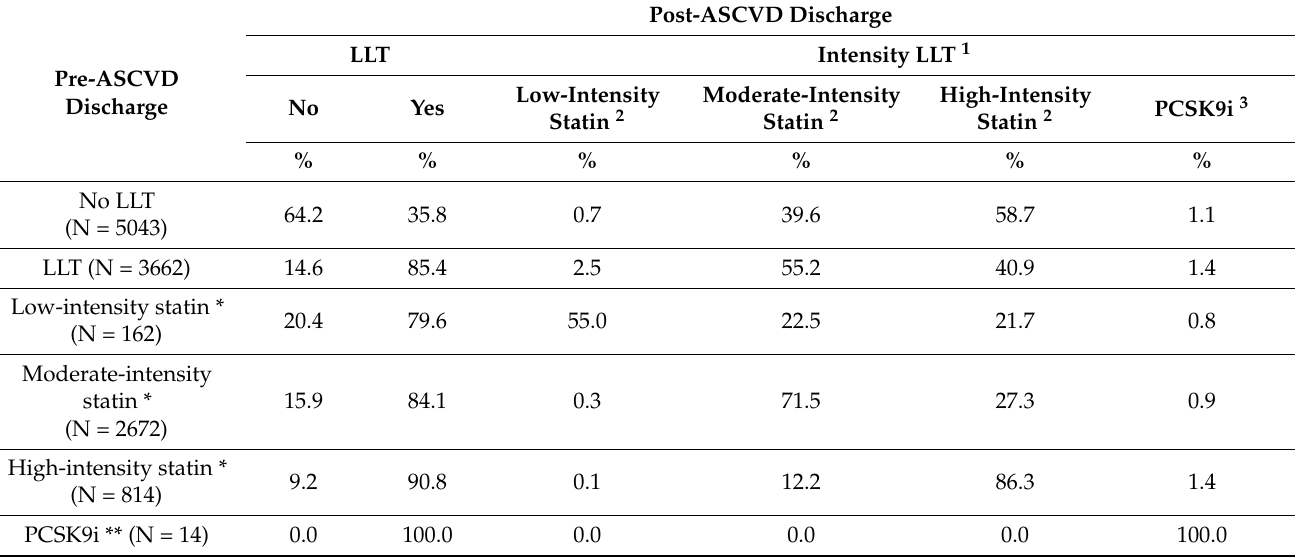
Table 3. Matrix analysis of LDL-C-lowering drug